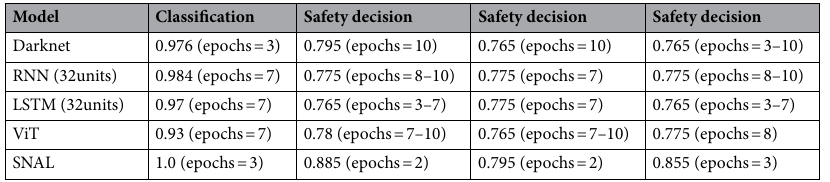
Table 2. Comparison of accuracy of each model under different tasks. 1. non sequential scenario, 2. sequential scenario train and test, 3. sequential scenario test